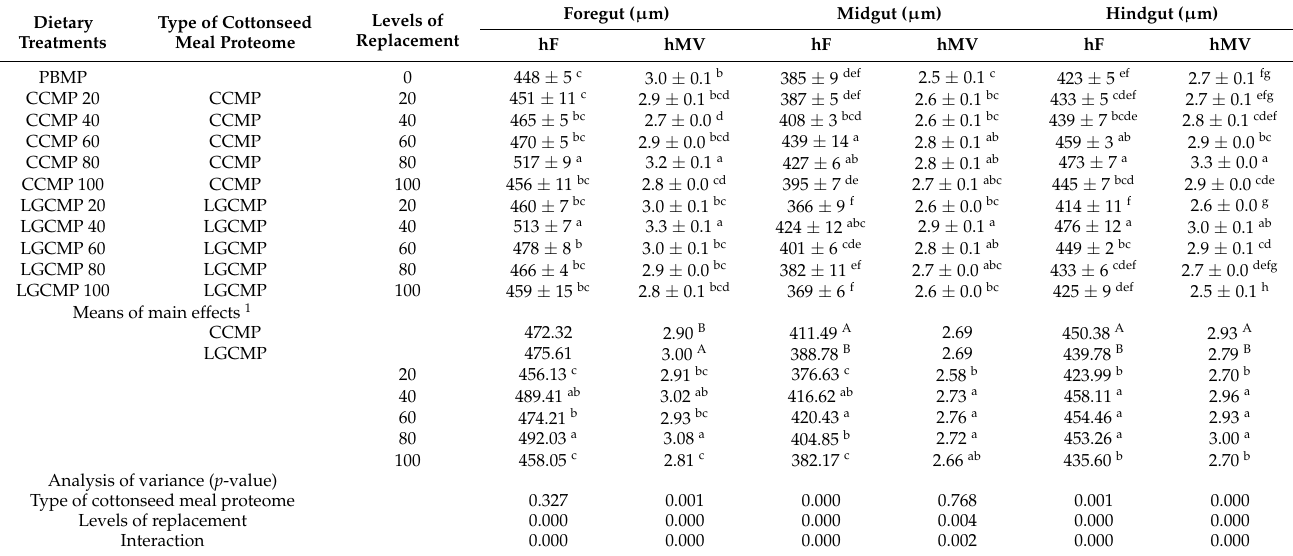
Table 6. Gut histology of hybrid grouper juveniles fed different experimental diets for 9